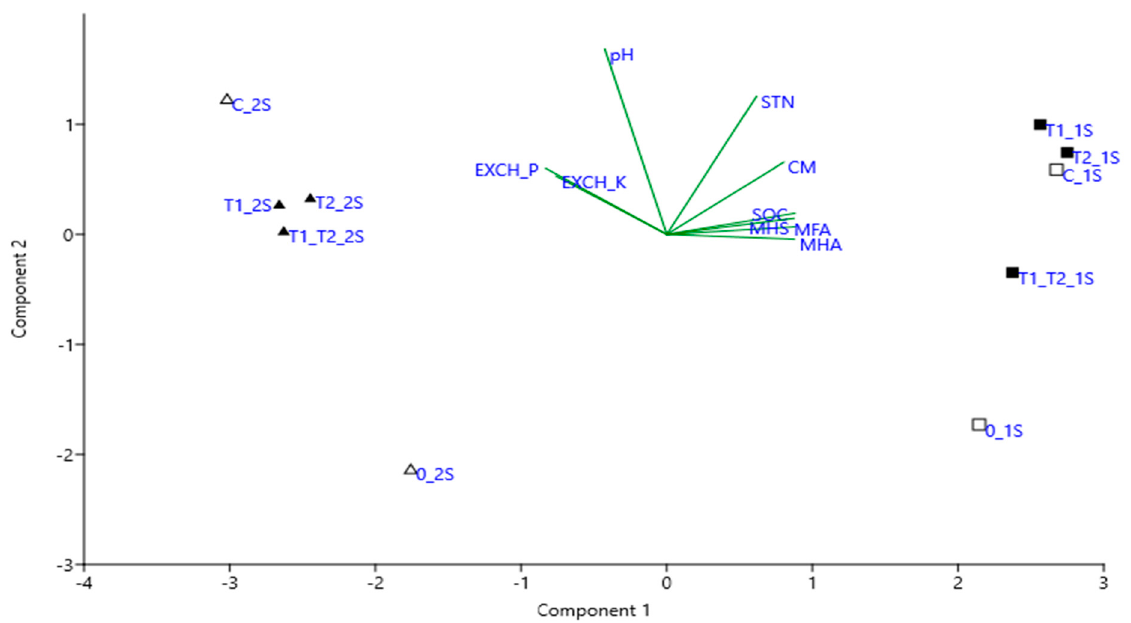
Figure 3. PCA diagrams for variables in experiment on Trichoderma spp. inoculated soil originated from different land-use systems. 0_1S—original grassland, C_1S—grassland non-inoculated, T1_1S— grassland inoculated with T. tomentosum , T2_1S—grassland inoculated with T. ghanense , T1_T2_1S— inoculated with the complex T. tomentosum + T. ghanense , 0_2S—original arable soil, C_2S—arable soil non-inoculated, T1_2S—arable soil inoculated with T. tomentosum , T2_2S—arable soil inoculated with T. ghanense , T1_T2_2S—inoculated with the complex T. tomentosum + T. ghanense .